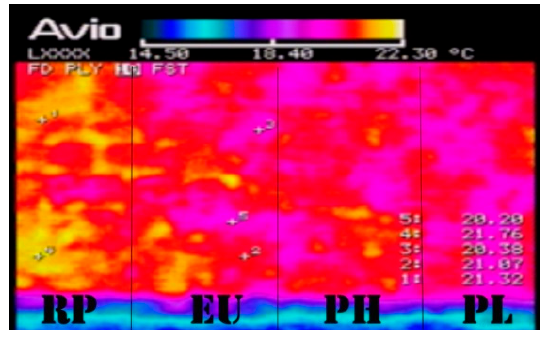
Figure 15. Thermogram of investigated-consolidated masonry.